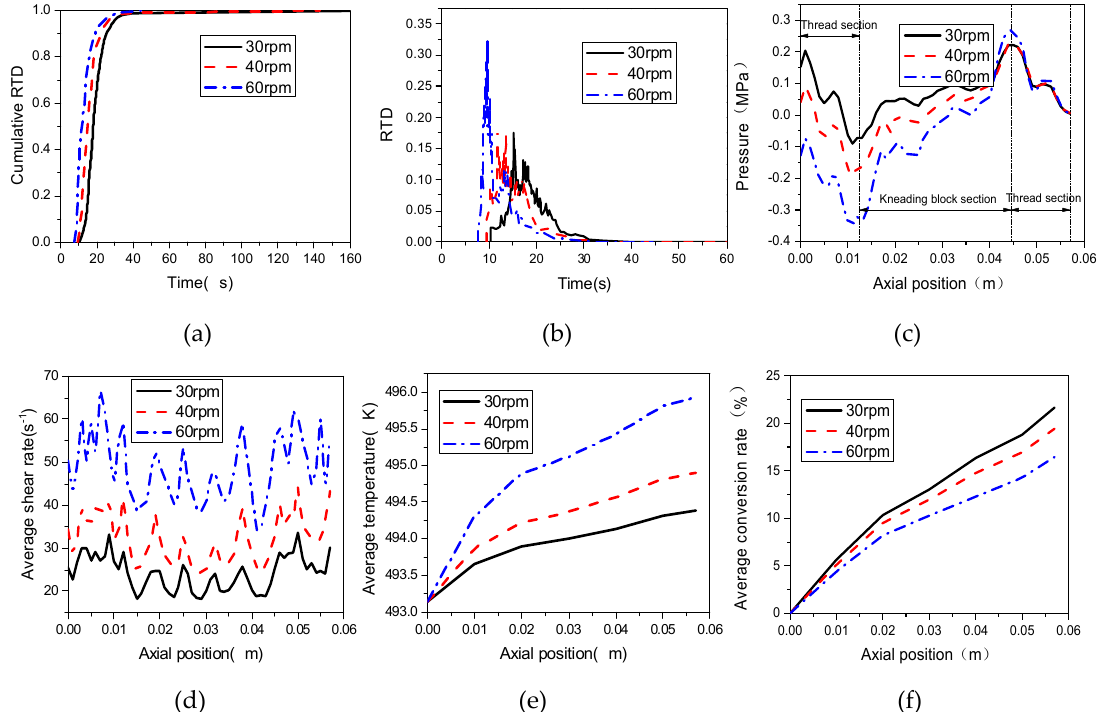
Figure 11. Effect of screw speeds on ( a ) cumulative RTD; ( b ) RTD; ( c ) pressure; ( d ) average shear rate; ( e ) average temperature; ( f ) conversion rate.